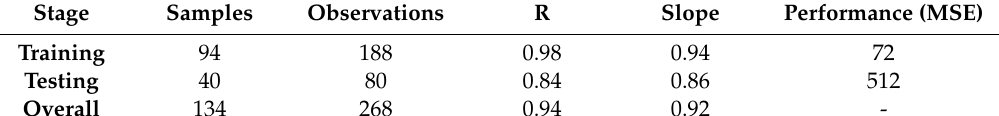
Table 2. Results of the artificial neural networks regression model (Model 2) showing statistical data such as correlation coefficient (R), slope, and performance based on means squared error (MSE) for each stage.